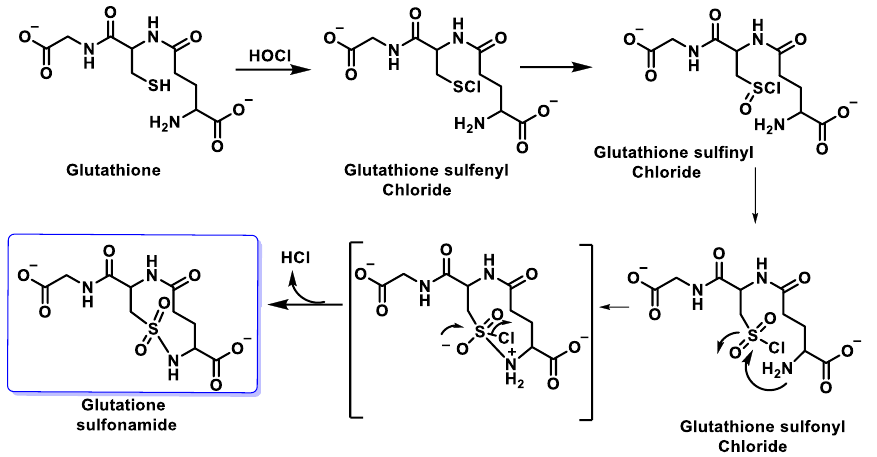
Figure 37. Intramolecular cyclisation of the RSCl intermediate with the terminal amino group on oxidation by hypochlorous acid. The proposed mechanism of formation is through the condensation of the sulphonyl chloride with the amino group of the glutamyl residue of glutathione. In human red cells, GSH is oxidised to glutathione disulphide GSSG; therefore, GSH probably acts as a protector of cells against HOCl toxicity [100]. Vissers et al., 1995,